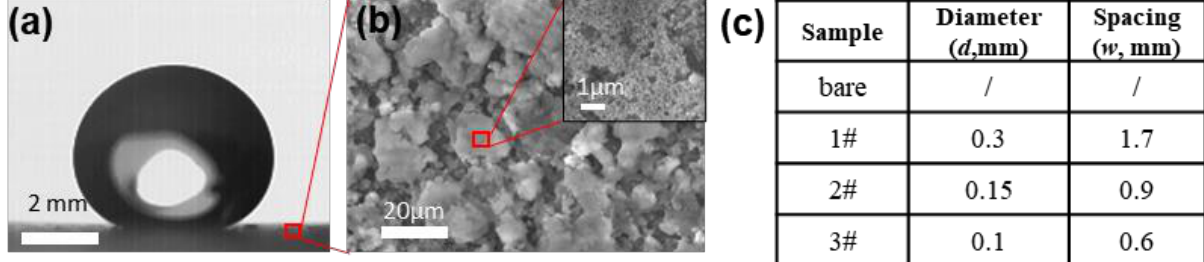
Figure 1. ( a ) Contact angle of a droplet on the surface coated with the superhydrophobic coating. ( b ) SEM image of the superhydrophobic coating. ( c ) Size of the tested mesh, where d and w are the diameter of the mesh fiber and the spacing of the fibers of the mesh, respectively.